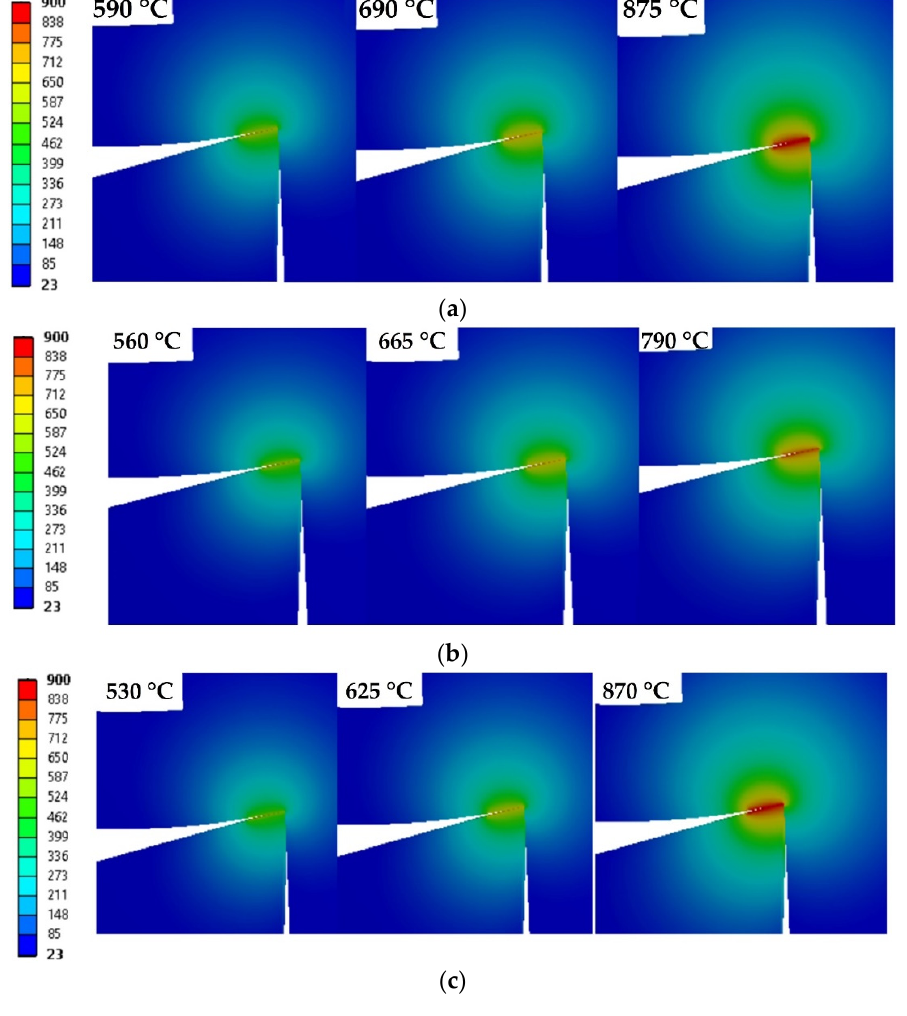
Figure 9. Temperature change on pads of uncoated ( a ), TiN–AlN–TiAlN-coated ( b ), and CrAlSiN– DLC-coated ball end mills ( c ) measured by natural thermocouple when machining nickel alloy at different cutting speeds and visualized by Deform software module; left to right: 150, 200, and 250 m/min.